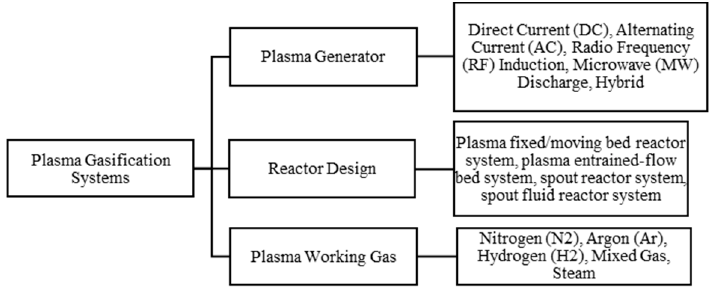
Figure 1. Classifications of plasma gasification systems. Table 1. Advantages of MW plasma gasification